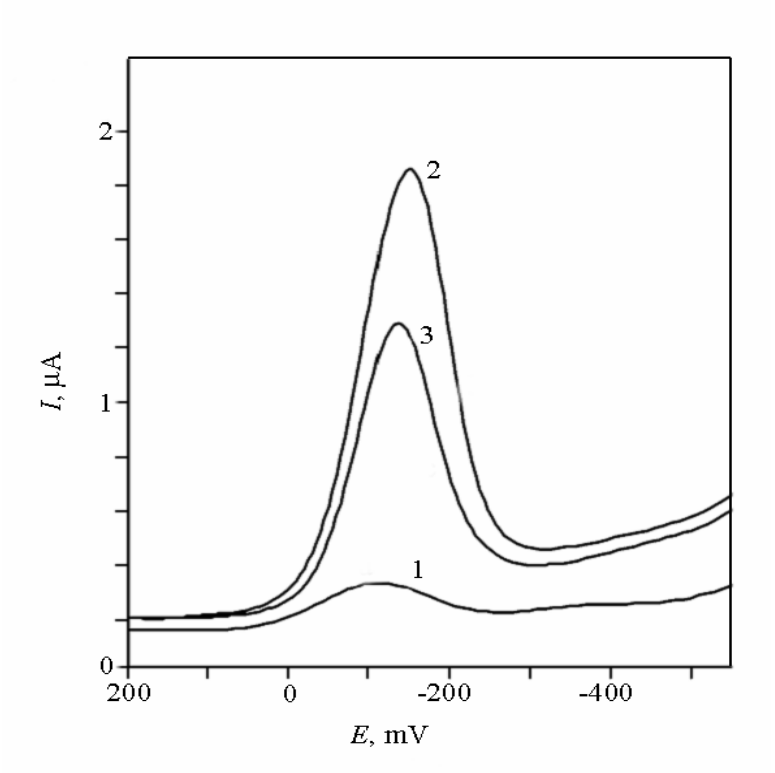
Figure 2. DP voltammograms of [Co(phen) after (3) incubation in model cleavage mixture. Conditions: 5x10 -7 mol/L [Co(phen) mol/L phosphate buffer solution pH 7.0, 120 s accumulation at +0.300 V, scan rate 10